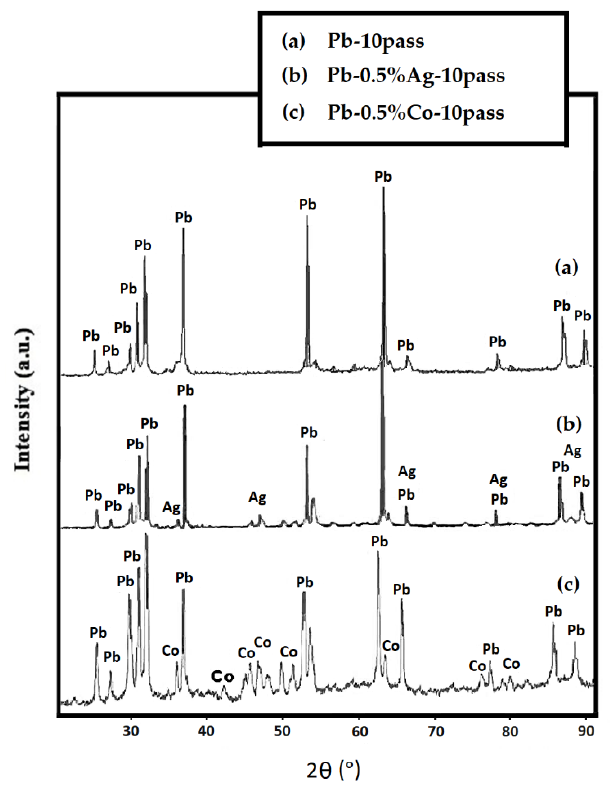
Figure 8. XRD pattern of ( a ) Pb – 10pass, ( b ) Pb – 0.5%Ag – 10pass, and ( c ) Pb – 0.5%Co – 10pass.